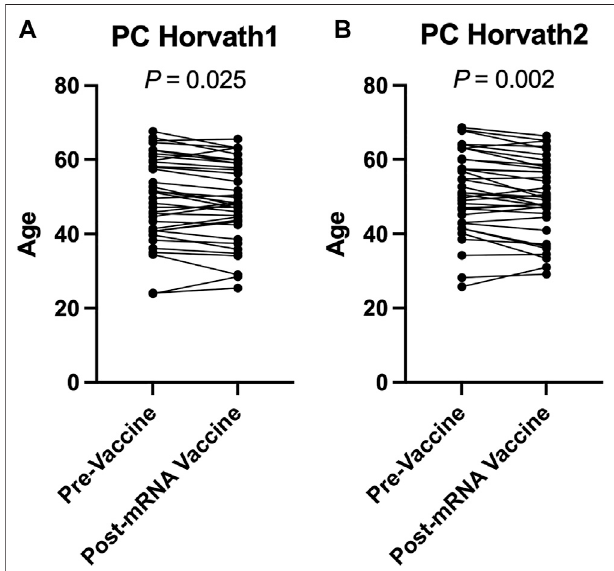
FIGURE 6 | mRNA COVID-19 vaccination decreases PCHorvath1 and PCHorvath2 epigenetic age (A) Longitudinal plot of individuals PCHorvath1 and (B) PCHorvath2 epigenetic age at pre-vaccine and post-mRNA vaccination time points. Paired t -test p -value